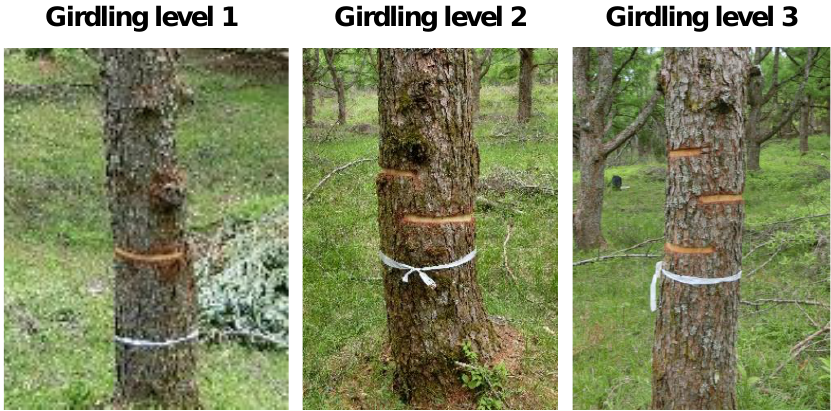
Figure A1. Example photos for girdling levels 1–3.